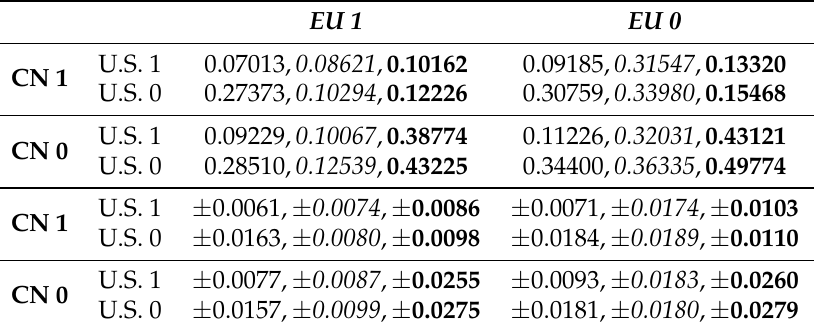
Table 4. Risk matrix (top) and corresponding 95% confidence intervals (bottom) for a three-player two-action game. Players are the U.S., EU and China, the font type shows risk values belonging to each player.